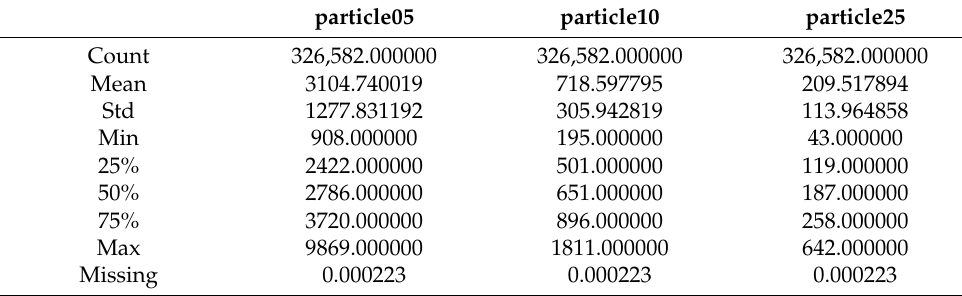
Table 1. Descriptive statistics–particle-matter